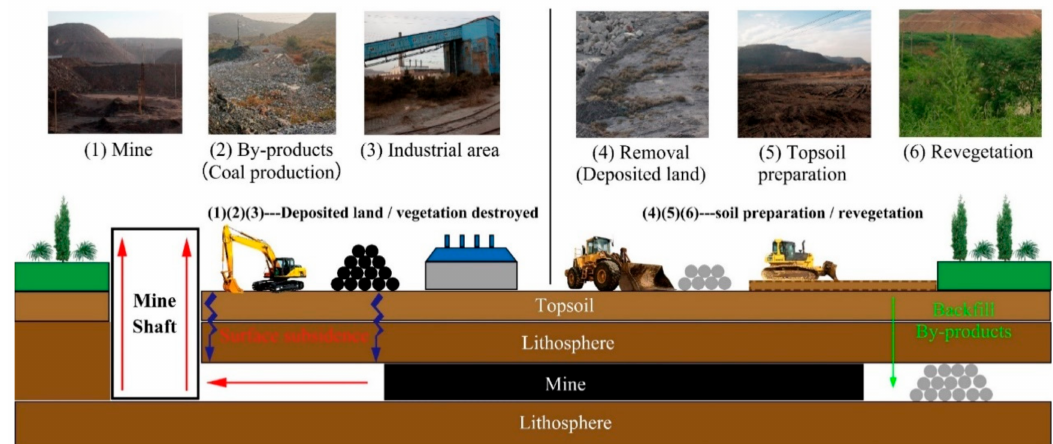
Figure 6. The process and reclamation of underground